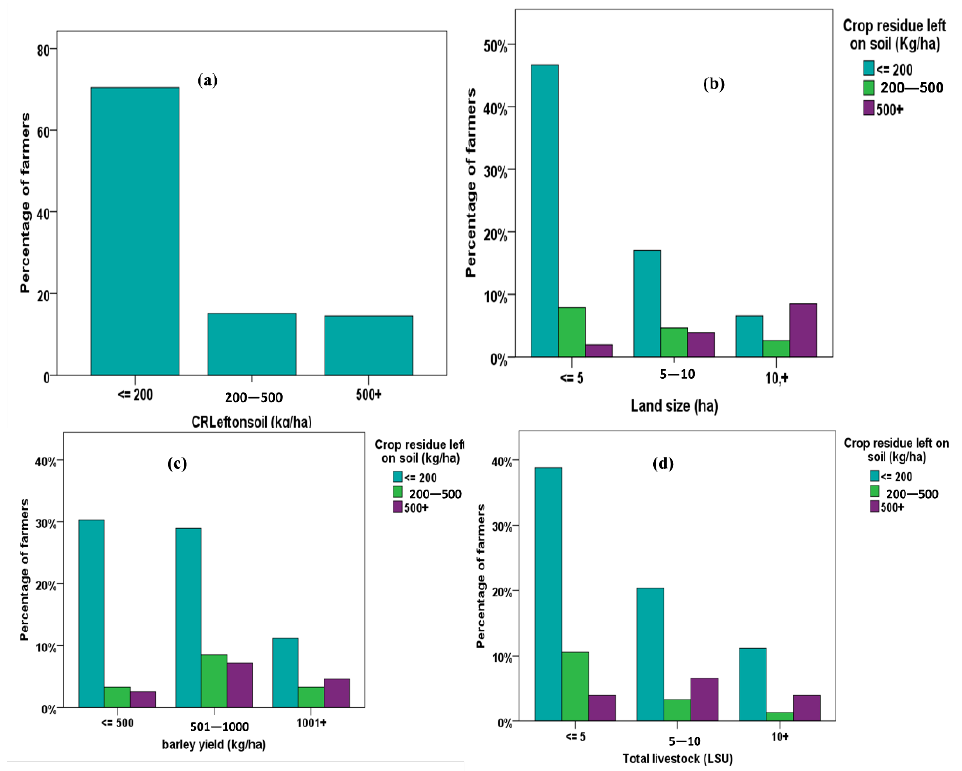
Figure 3. Distribution of the quantity of crop residues left on the soil ( a ) and quantity of crop residue left on the soil as function of total land size ( b ), barley yield ( c ), and number of livestock (expressed as LSU) ( d ).